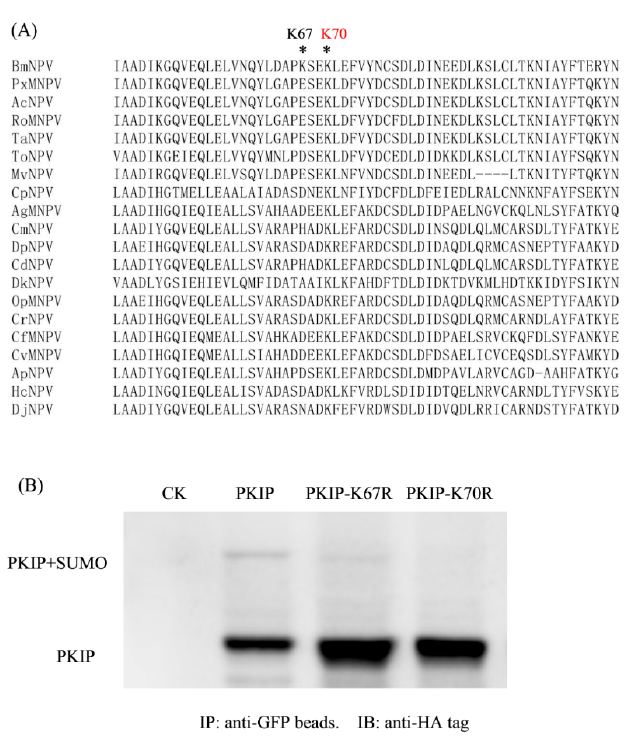
Figure 3. Ginkgolic acid (GA) inhibited BmNPV replication. ( A ) Fluorescence of V Bm-EGFP -infected BmN cells under treatment with different concentrations of ginkgolic acid at 48 hpi. Bar = 100 µ m. ( B ) The budded virus titer curve of V Bm-EGFP under ginkgolic acid treatment. ( C ) DNA copies of BmNPV at 48 hpi. The error bars indicate the SDs of averages from three independent experiments with three technical replicates. Statistical analysis was applied with SPSS software. One-way ANOVA with Tukey’s post-test was used. Significant differences are indicated by asterisks (* p < 0.05; *** p < 0.001).